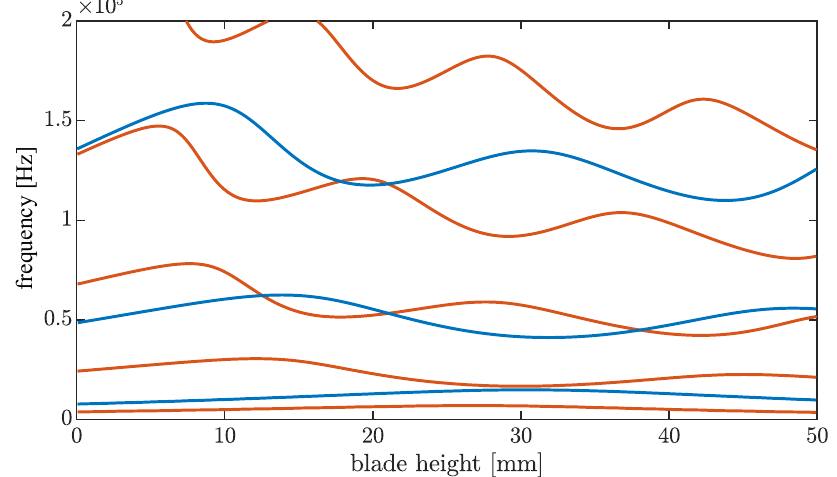
Figure 5. The fluctuation of the natural frequencies in the function of the blade height for both x and y directional bending modes calculated by the simplified analytical